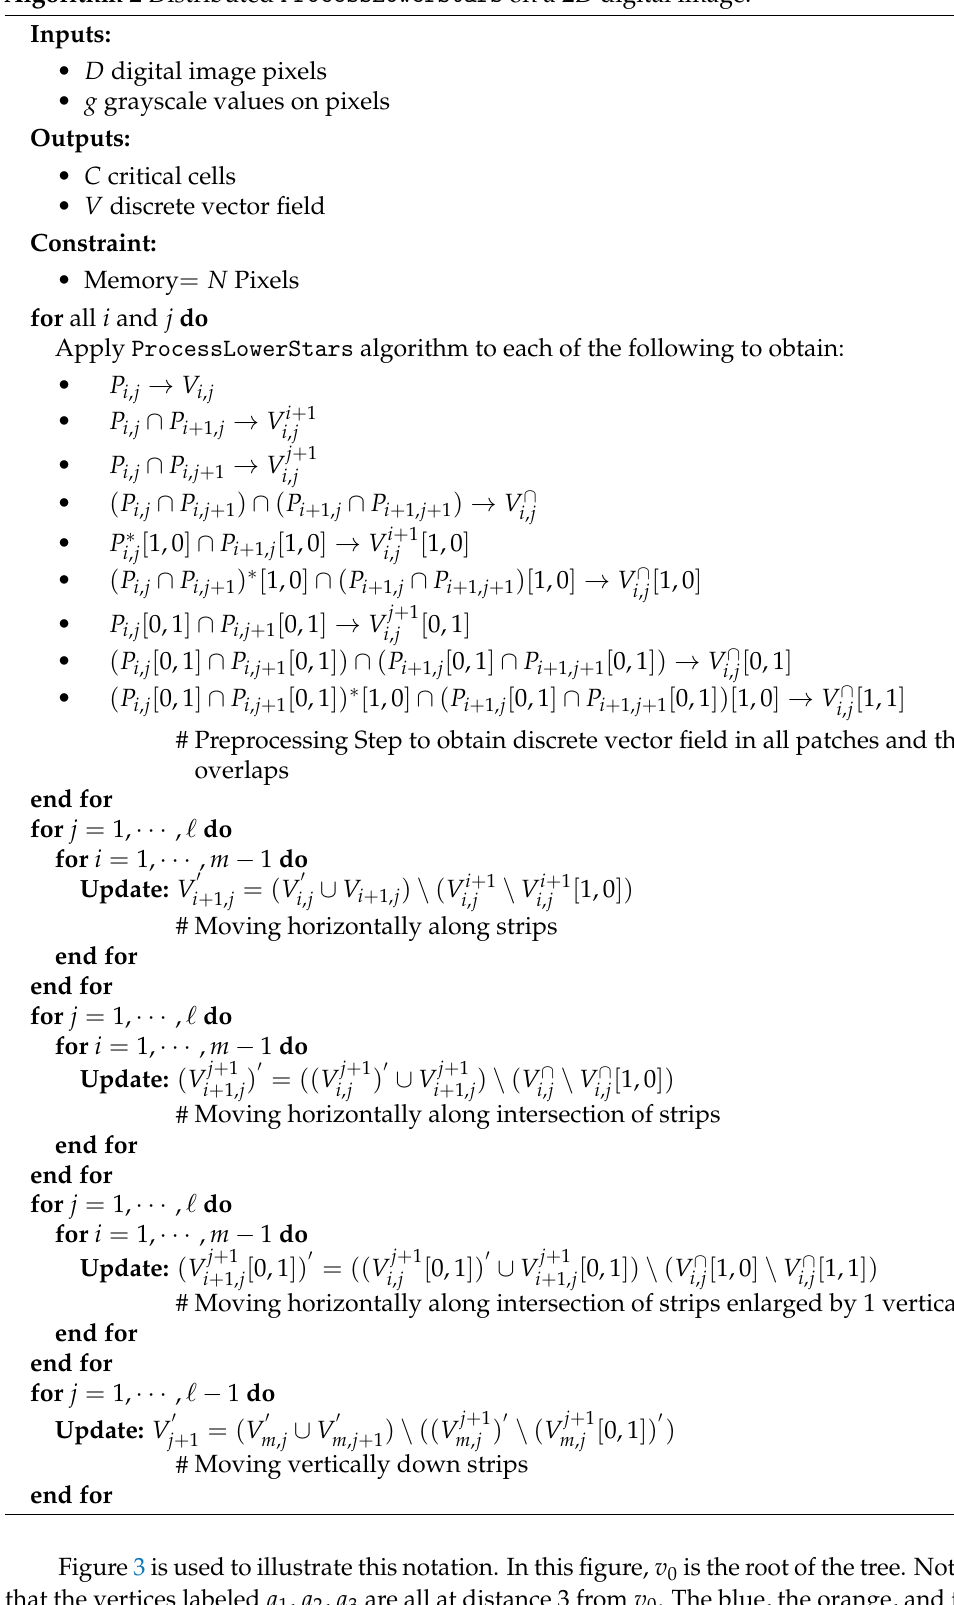
Algorithm 2 Distributed ProcessLowerStars on a 2D digital